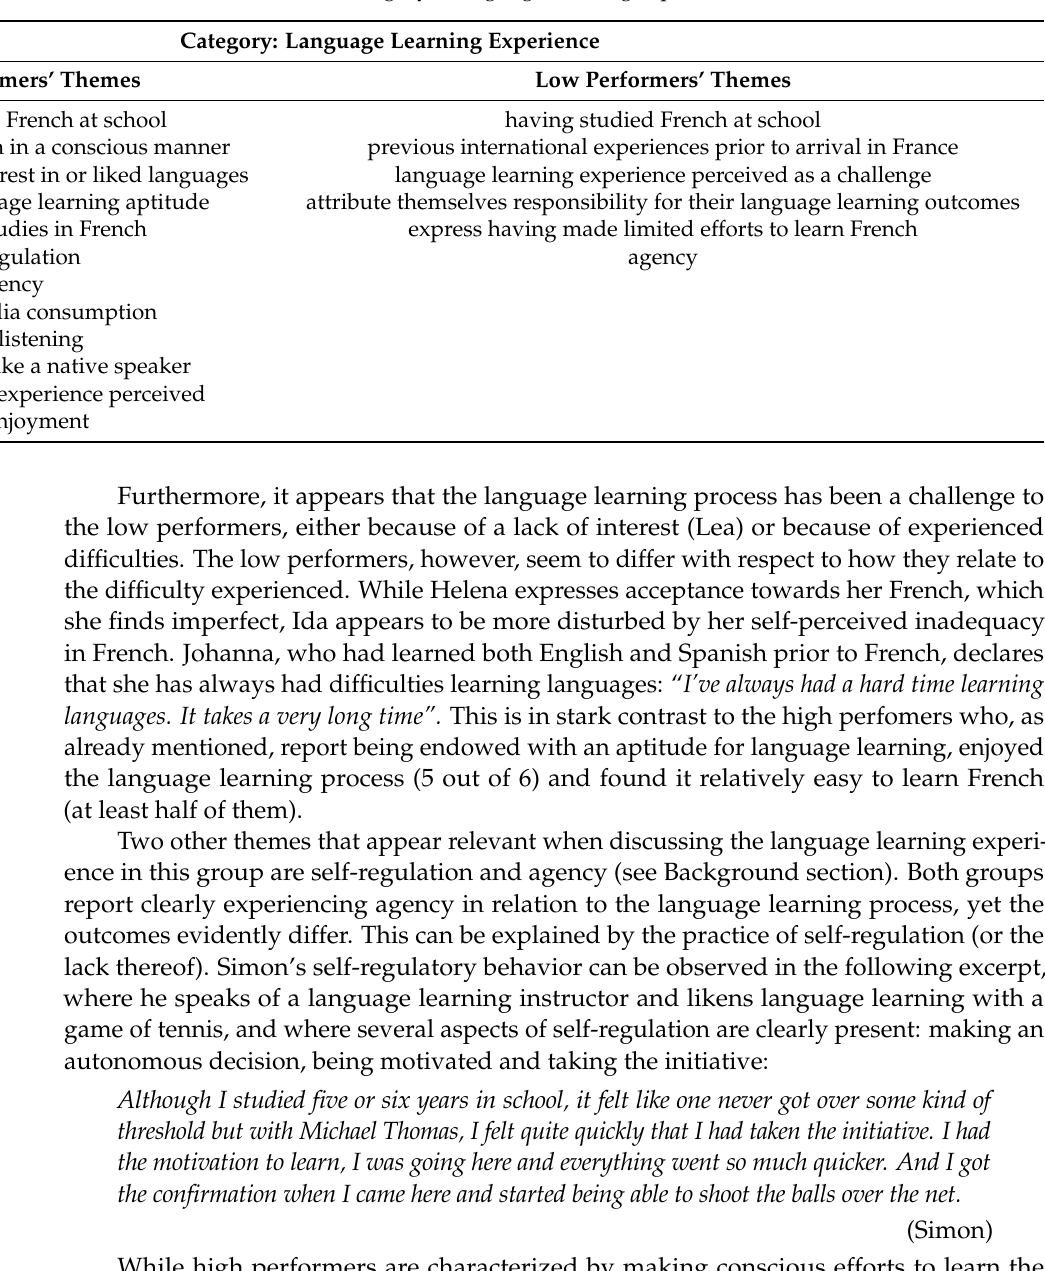
Table 4. Identified themes in the category “Language learning